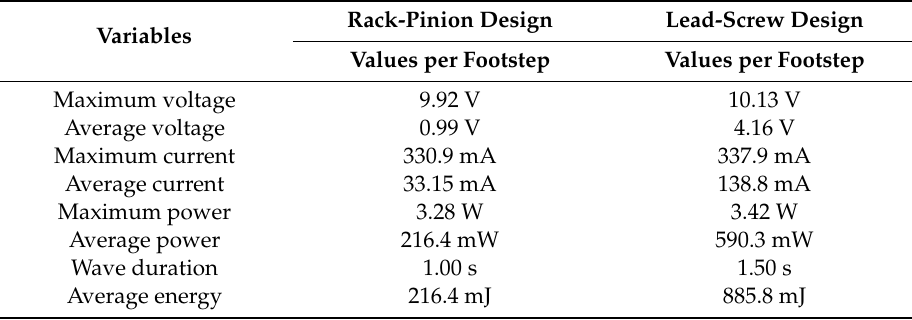
Table 3. Performances of the EM-generator designs.